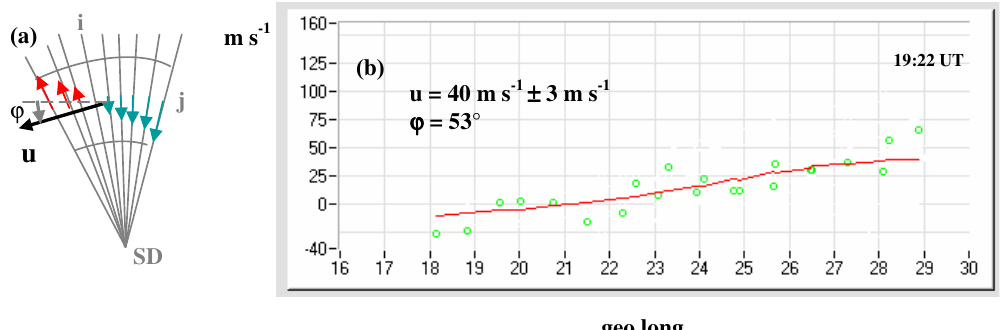
Fig. 8. (a) Sketch that illustrates projection of plasma velocity along the radar beams. (b) Beam-aligned plasma velocities calculated from Doppler shift of HF signal (green circles) and the fit (red line) which allows to deduce the velocity vector in the plane perpendicular to magnetic field.